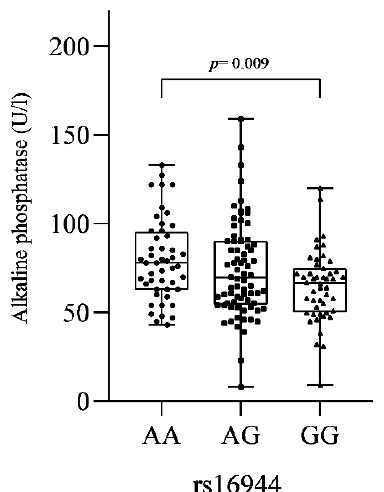
Figure 2. Comparison of alkaline phosphatase levels according to genotypes of single-nucleotide variant rs16944 in IL-1 β gene. Statistical tests: p -value Kruskall–Wallis = 0.012; p -value Dunn’s post hoc test = 0.009 (AA vs. GG genotype).